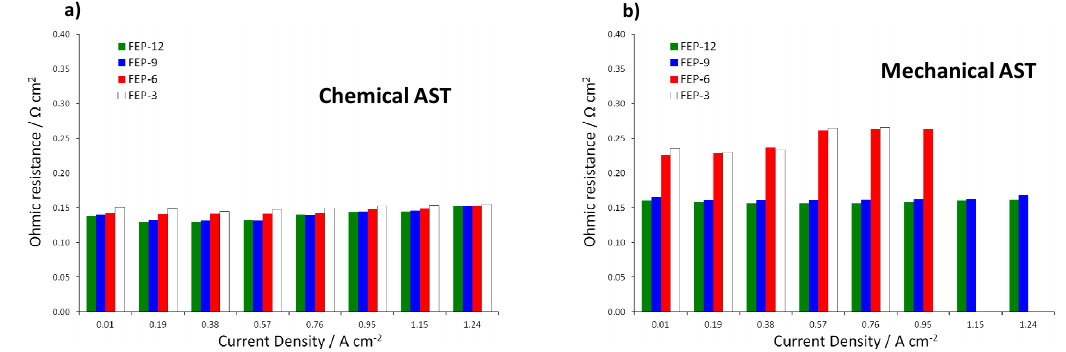
Figure 7. Ohmic resistance as a function of current density upon: chemical ( a ); and mechanical ( b ) ASTs on all the prepared GDMs. Notice that missing values are due to sudden voltage drop at medium-high current density for mechanically aged FEP-3 and FEP-6 samples.